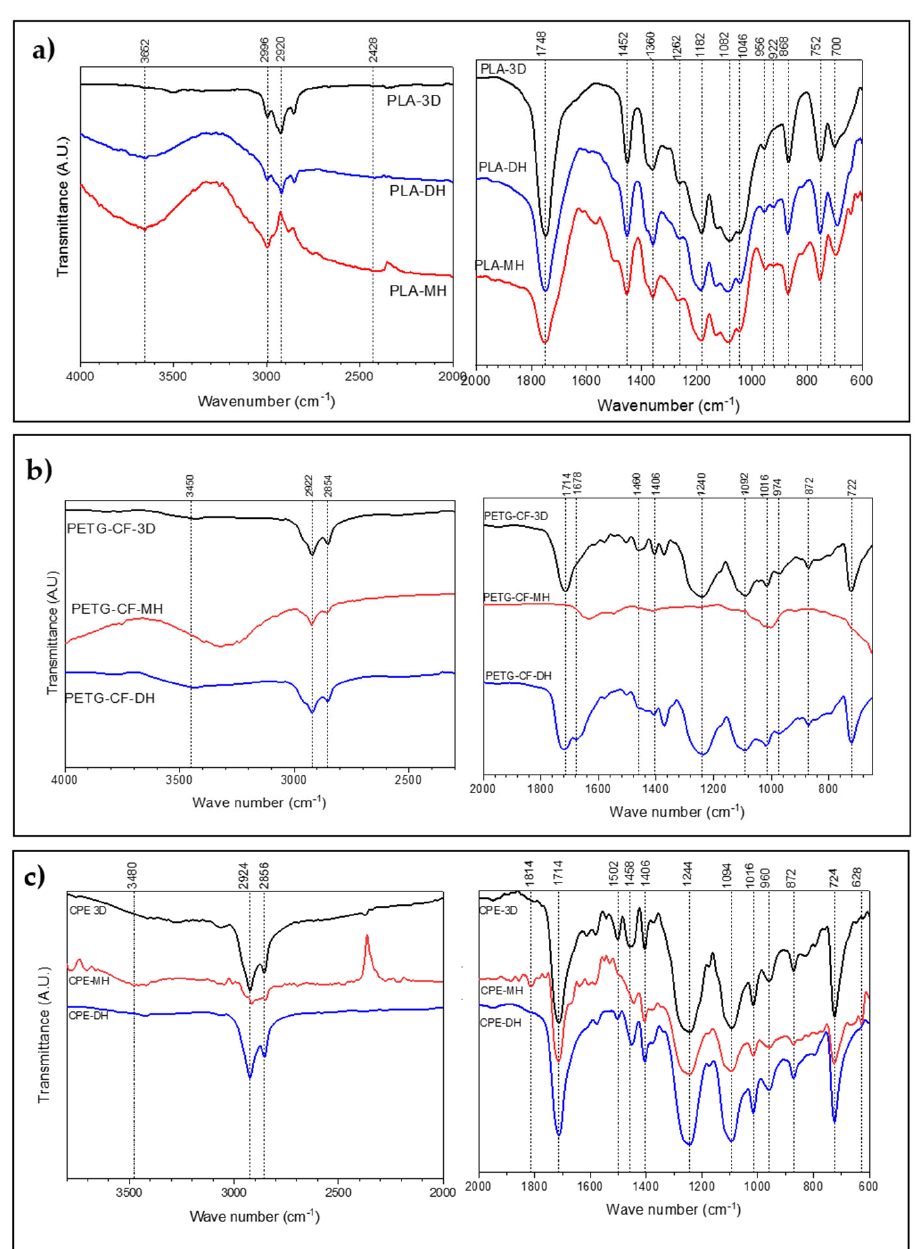
Figure 14. ATR ‐ FTIR analysis before and after the sterilization treatments of 3D printed samples of